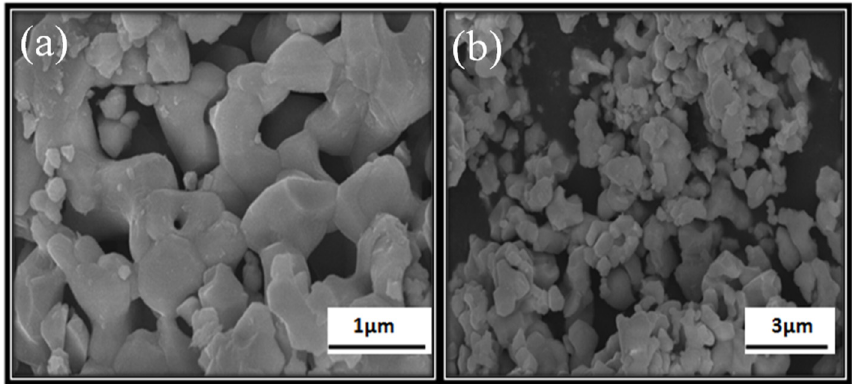
Figure 4. SEM images of BST ‒ BZT at certain magnification at scale of ( a ) 1µm, and ( b ) 3µm. The chemical composition of the BST-BZT powder was determined using the XPS technique. Figure 5a shows the XPS survey (0–1000 eV binding energy) of BST-BZT ceramic powder revealing that Ba, Zr, Sr, Ti, and O elements were present in the composition. Furthermore, the XPS spectrum was calibrated according to the binding energy of carbon (~285 eV). Each element was deconvoluted into the peaks using linear as a background. In the C1s spectrum shown in Figure 5b, the obtained binding energy at ~284.6 eV and ~288 eV is due to the C-C/C-H bond and carbonates [38]. The Ba XPS survey in Figure 5c shows that Ba3d3/2 and Ba3d5/2 peaks can be fitted around at a difference of ~1.5 eV. The binding energies ~794.16 and ~778 eV are due to the Ba atoms in BST-BZT ceramics, whereas the peaks around ~779.6 and ~795.18 eV are assigned to Ba atoms obtained during decomposed barium carbonate layers [39]. The O1s spectra can be deconvoluted into three peaks shown in Figure 5d centered at ~528.97 eV, ~531.09 eV, and ~532.83 eV, which are assigned to the oxygen lattice in the sample, oxygen vacancy, and adsorbed oxygen, respectively [40]. Although a peak at ~531.09 eV does not directly indicate the detection of oxygen vacancies, it helps in identifying the adsorbed O − , O 2 − , and –OH groups trapped in formal oxygen vacancies in synthesized material [41,42], whereas higher binding energy at ~532.83 eV is generally due to the chemisorbed and oxygen-dissociated species. Furthermore, the Sr3d peaks can be deconvoluted at ~132.5 and 134.32 eV binding energies as shown in Figure 5e. The peaks shown in Figure 5f fitted perfectly at binding energy ~458 eV and ~464 eV, which is attributed to the Ti2p3/2 and Ti2p1/2 core level with Ti 4+ cations [43]. Figure 5g shows profiles representing two-spin orbit peaks of Zr, i.e., the 3d5/2 peak at a binding energy of ~176.4 eV and the 3d3/2 peak at a binding energy of ~178.0 eV. Figure 6 shows the absorbance spectrum of BST-BZT powder sample in a range of 200–800 nm wavelength. The powder sample absorbs much less energy in the range of 500–800 nm wavelength, however there is a gradual increment in the absorbance in the range of 415–550 nm wavelength. After the 415 nm wavelength, there is a sudden rise in the absorption revealing the maximum absorption